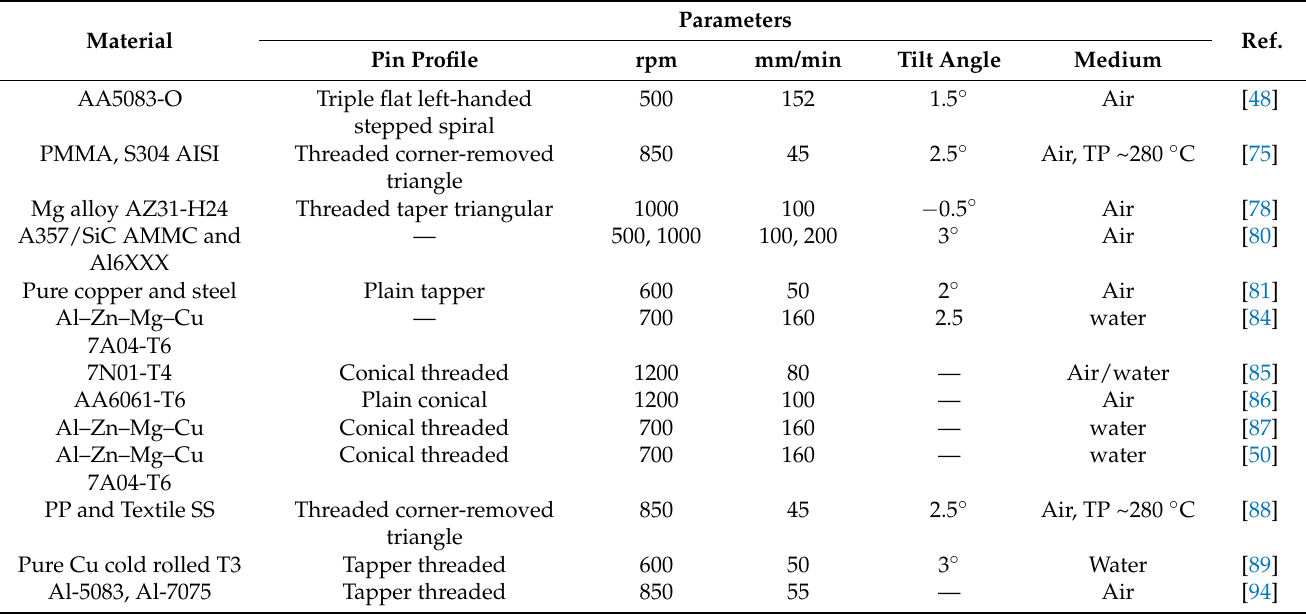
Table 4. Summary of material and optimized set of parameters for successful defect-free layered build fabricated to